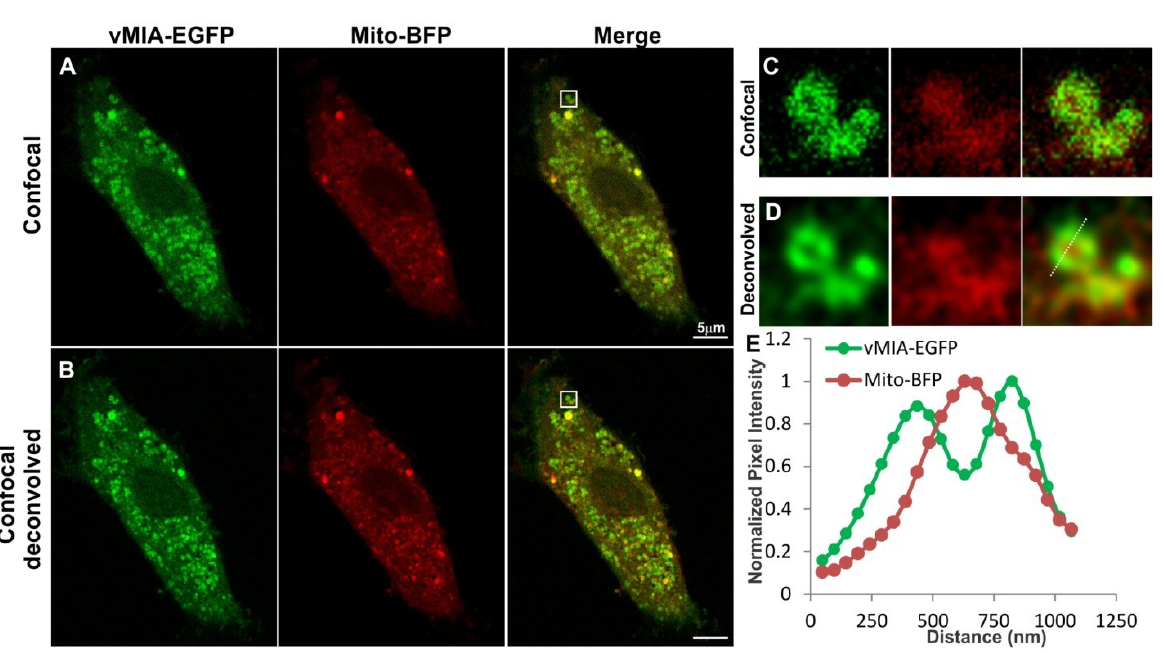
Figure 2. Monitoring mitochondrial localization of vMIA by confocal microscopy. Primary human foreskin fibroblasts (HFFs) lipofected with vectors expressing vMIA- EGFP and Mito-BFP were fixed with 4% paraformaldehyde (PFA) at 22 hours after transfection as described in the methods. ( A ) Images show a single optical plane for a cell expressing vMIA-EGFP (green) and Mito-BFP (pseudocolored red) imaged using confocal microscopy and ( B ) the same image plane following deconvolution of the entire Z-stack. ( C , D ) The boxed region of interest is enlarged on the right. ( E ) Intensity profile of vMIA-EGFP (green) and Mito-BFP (red) emissions along the pixels marked by the dotted line on the deconvolved image are shown by the plot. For higher resolution images, see Supplemental Figure